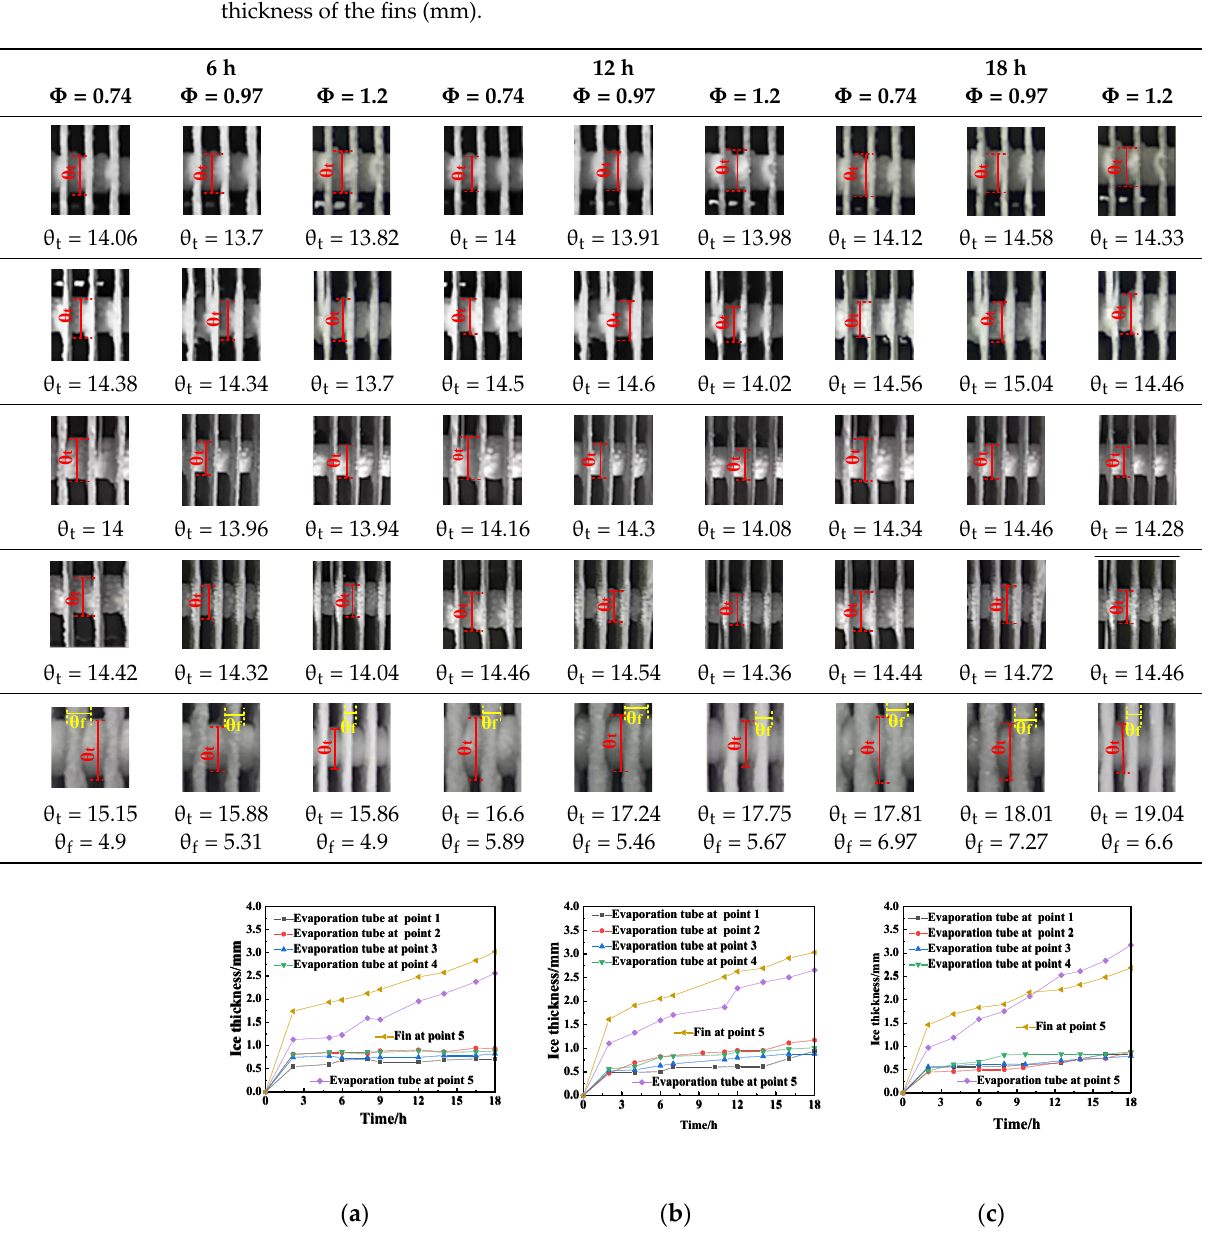
Figure 5. Frost curves of points to be measured under different plenum-chamber coefficients, which are 0.74 ( a ), 0.97 ( b ), and 1.2 ( c ), respectively.